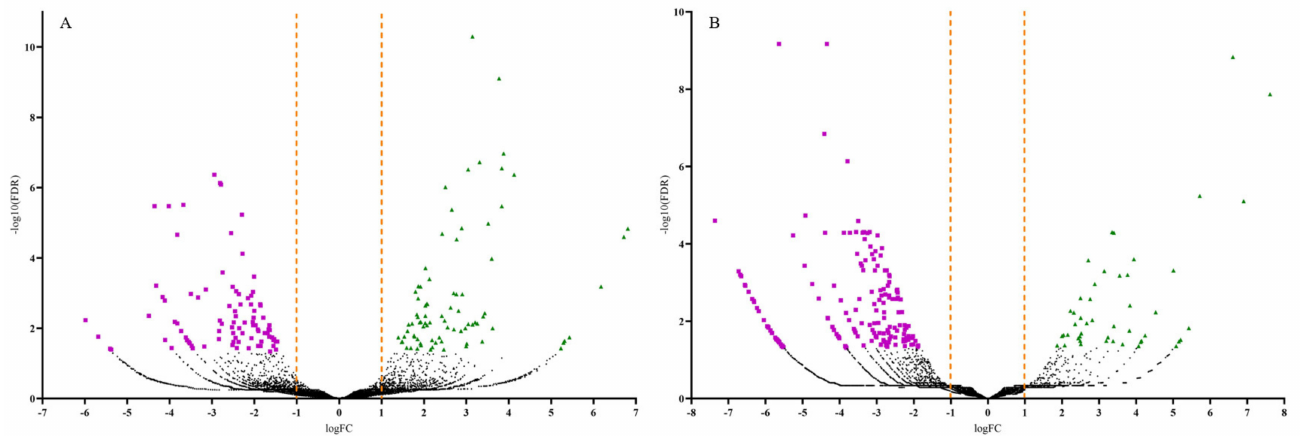
Figure 3. Volcano plots of the differentially expressed genes (DEGs) for both significantly upregu- lated and downregulated genes between non-infected and citrus dwarfing viroid (CDVd)-infected ( A ) stem and ( B ) root samples. Significantly upregulated (FDR < 0.05; logFC > 1.0) and downregulated (FDR < 0.05; logFC < − 1.0) genes are represented in green (triangles) and magenta (squares), respectively.